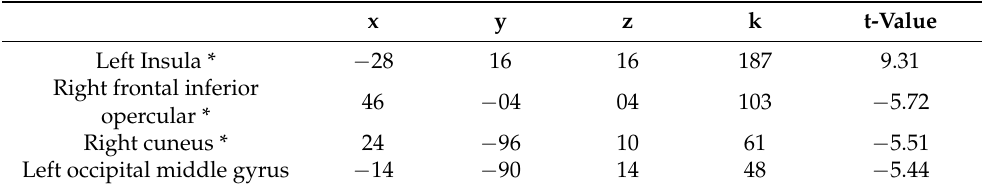
Table 2. Significant clusters for differences in functional connectivity between the vmPFC and the rest of the brain for self-biases compared to